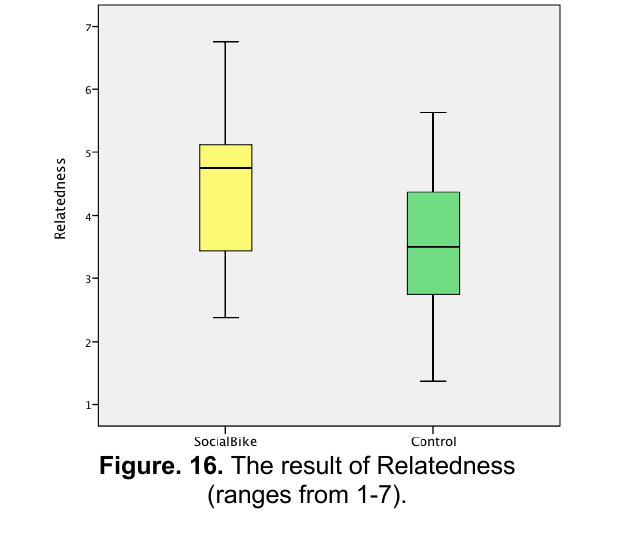
Figure. 16. The result of Relatedness (ranges from 1-7).